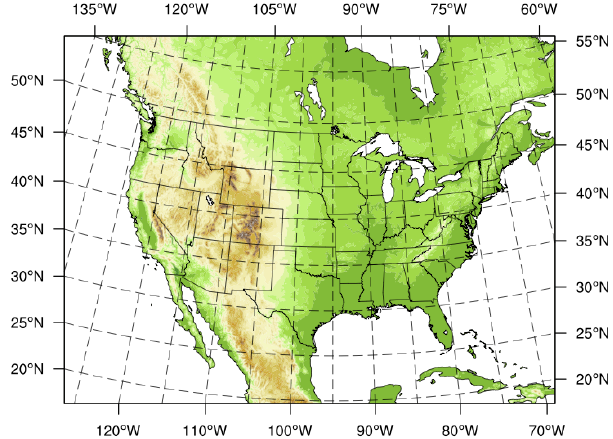
Figure 2. WRF domain over the conus area at the resolution of 15km. Based on this configuration, the 50 members coming from a 6h forecast (DART experiment) are used to generate background error